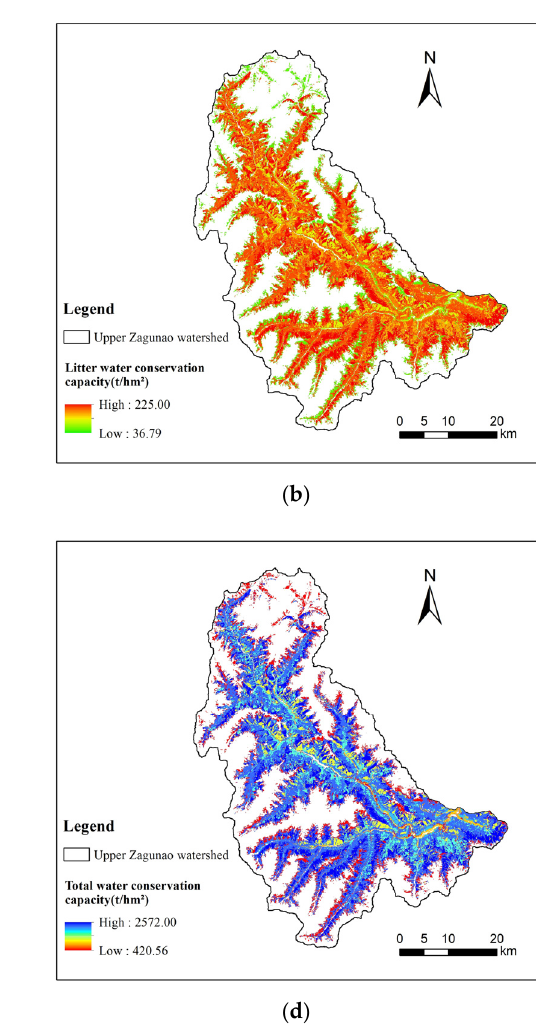
Figure 8. Spatial distribution of ( a ) canopy, ( b ) litter, ( c ) soil and ( d ) total water conservation capacity in 2010.